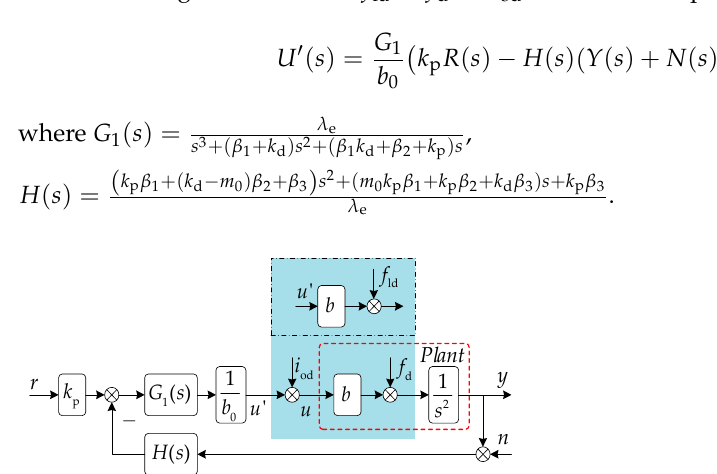
Figure 8. Simplified structure of the proposed LADRC scheme.